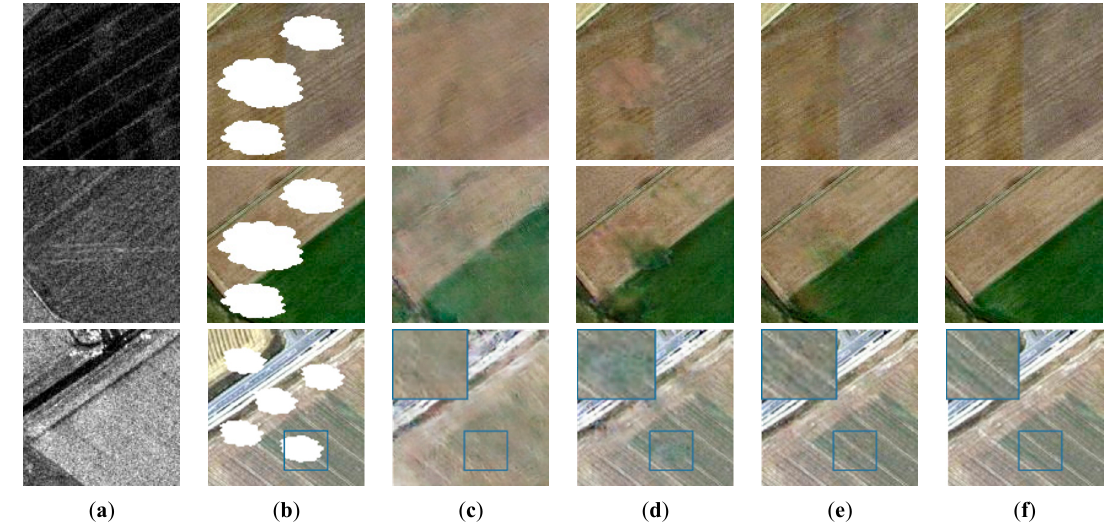
Figure 5. Results of each method in Dataset B. ( a ) original SAR images; ( b ) simulated corrupted images; ( c ) results of the pix2pix model; ( d ) results of the SAR-opt-GAN model; ( e ) results of the proposed model ( f ) ground truth.